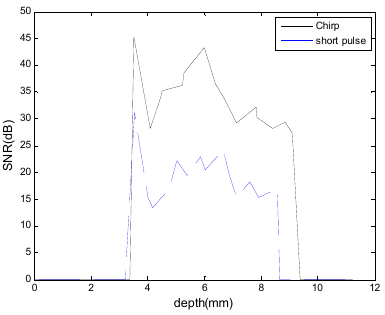
Figure 14. The signal ‐ to ‐ noise ratio as a function of depth.